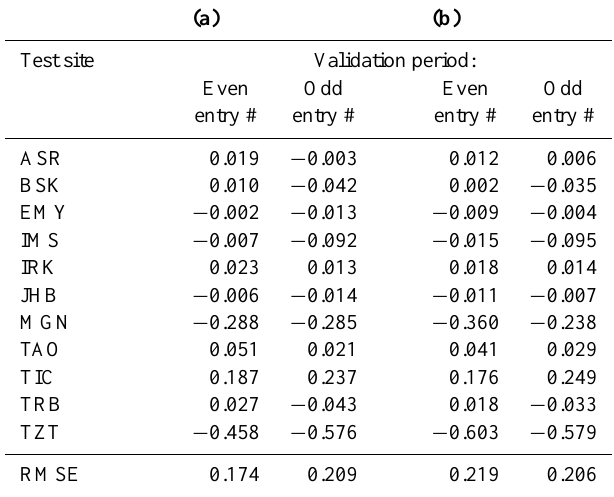
Table 4. Validation of p 0 estimation: Differences between calcula- tions and estimates ( c p 0 − p 0 ) and root mean squared errors (RMSE). (a) First reanalysis data is interpolated to the test sites and then p 0 is calculated. (b) p 0 is calculated at grid points and then